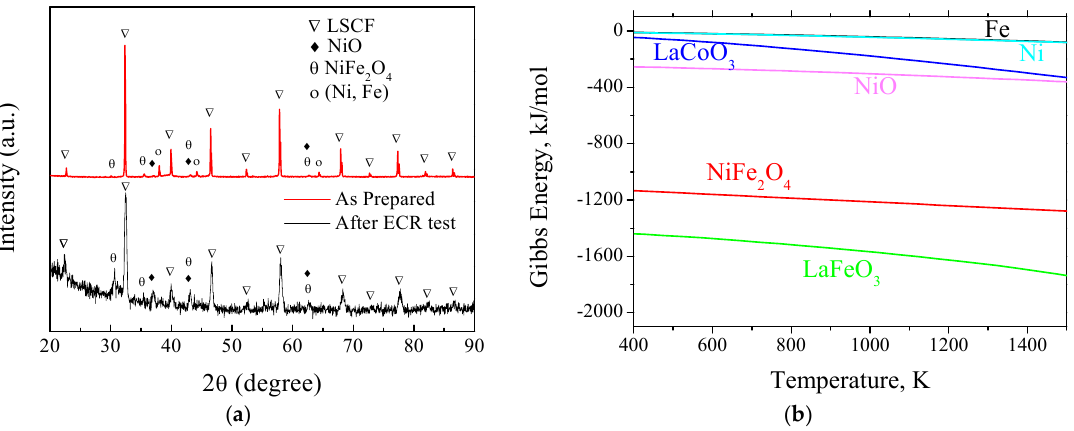
Figure 6. ( a ) X ‐ ray diffraction (XRD) patterns of the LSCF bar as prepared (1 h at 800 °C) and the one after the electrical conductivity relaxation (ECR) test; and the Gibbs energy of the various phases cited from the HSC Chemistry software ( b ).